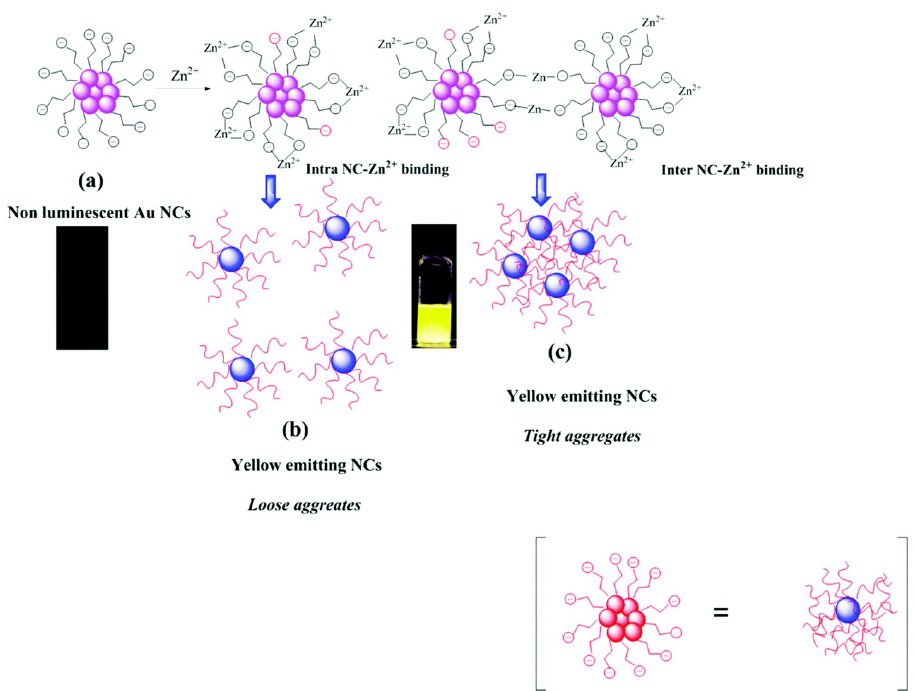
Figure 6. Schematic diagram of self-assembly between AuNCs and Zn 2+ . ( a ) Non-assembled nonluminescent-NCs, ( b ) Loose aggregates of yellow emitting-NCs, ( c ) Close aggregates of yellow emitting-NCs. Copyright 2017 Royal Society of Chemistry.